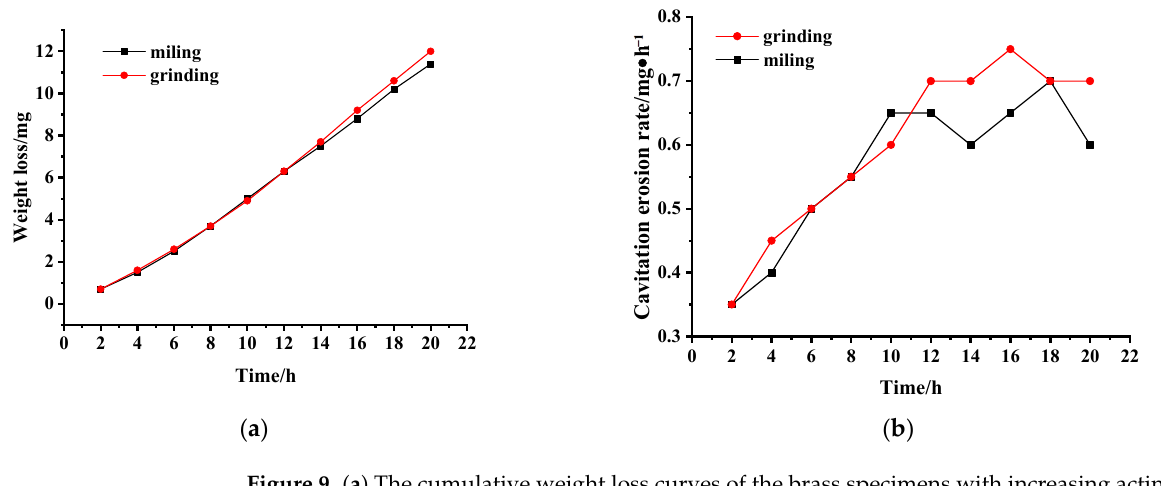
Figure 9. ( a ) The cumulative weight loss curves of the brass specimens with increasing acting time. ( b ) The cumulative weight loss curves of the brass specimens with increasing acting time.